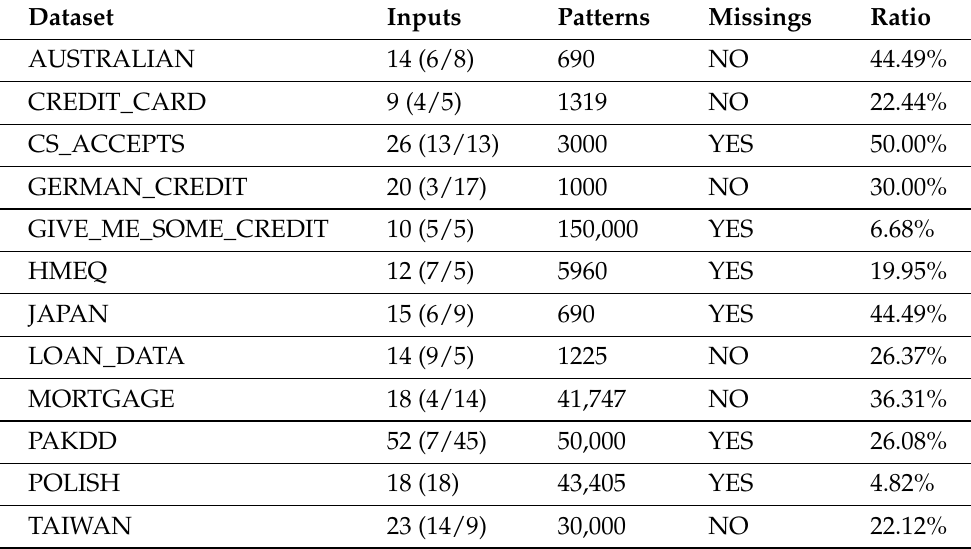
Table 8. Main details of the 12 datasets employed in the computational study: name of the dataset, number of inputs (number of numeric/categorical variables), number of observations, presence of missing values, and ratio between default and non-default